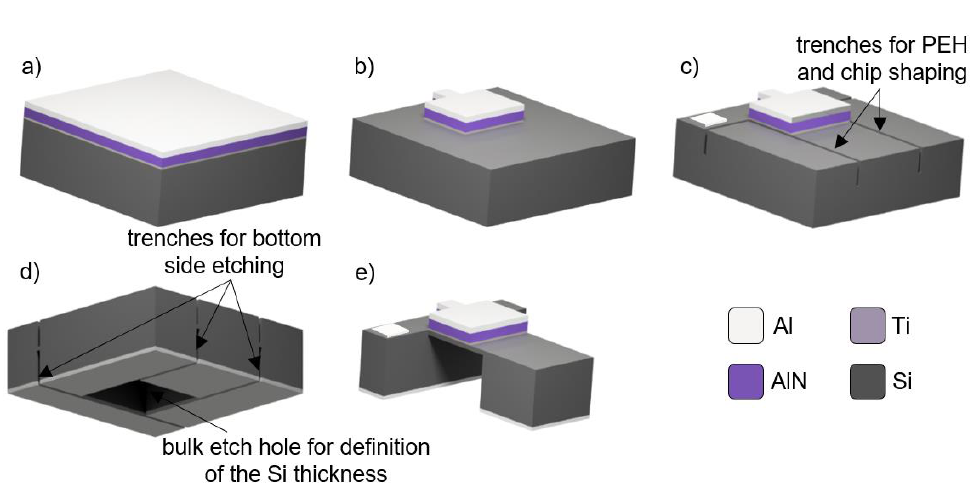
Figure 2. Fabrication process flow (not to scale): ( a ) Deposited layers on top side of Si substrate; ( b ) patterning of Ti/AlN/Ti/Al structure; ( c ) top-side trench etching using deep reactive ion etching (DRIE) method; ( d ) metallization followed by back-side etching causing separation of chips; ( e ) back-side etching, using DRIE method to form final structure.